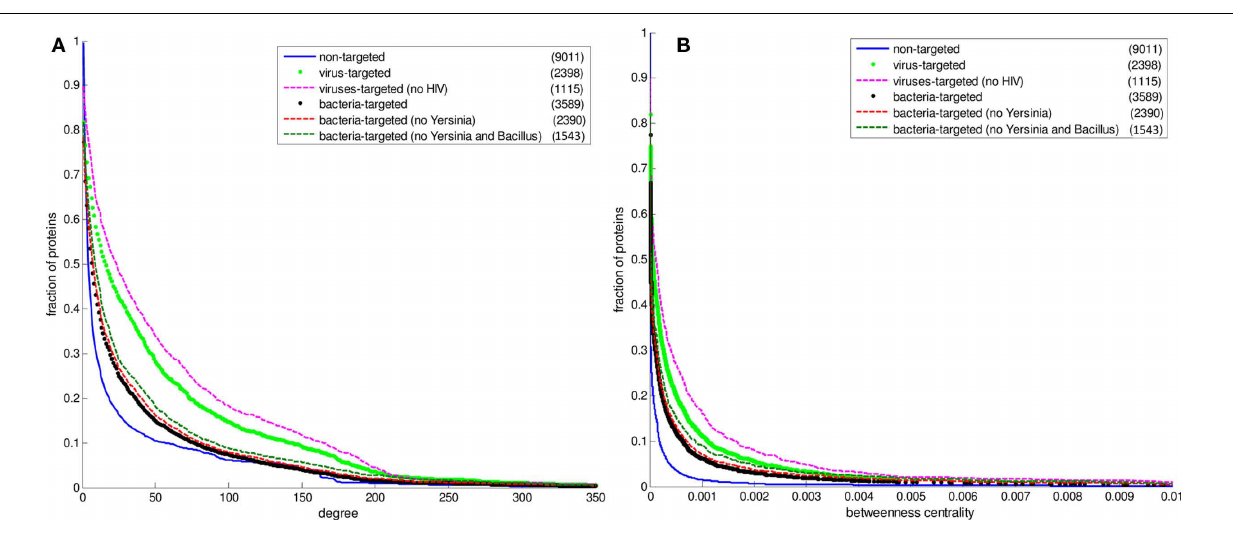
distributions (B) the betweenness centrality distributions.The fraction of proteins at a particular value of degree is the number of proteins having that value and greater divided by the number of proteins in the